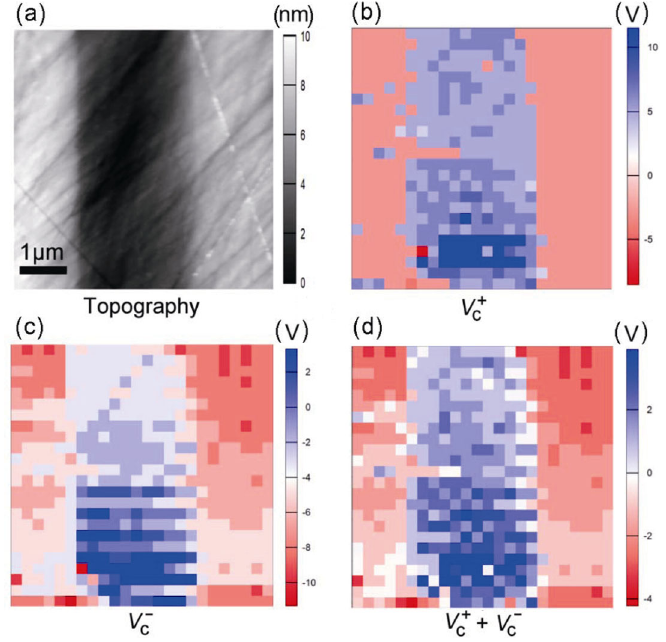
Fig. 3 (a) Surface topography and maps of switching parameters of the KNN single crystals obtained using SS-PFM: V  , (c) negative bias (b) positive bias c